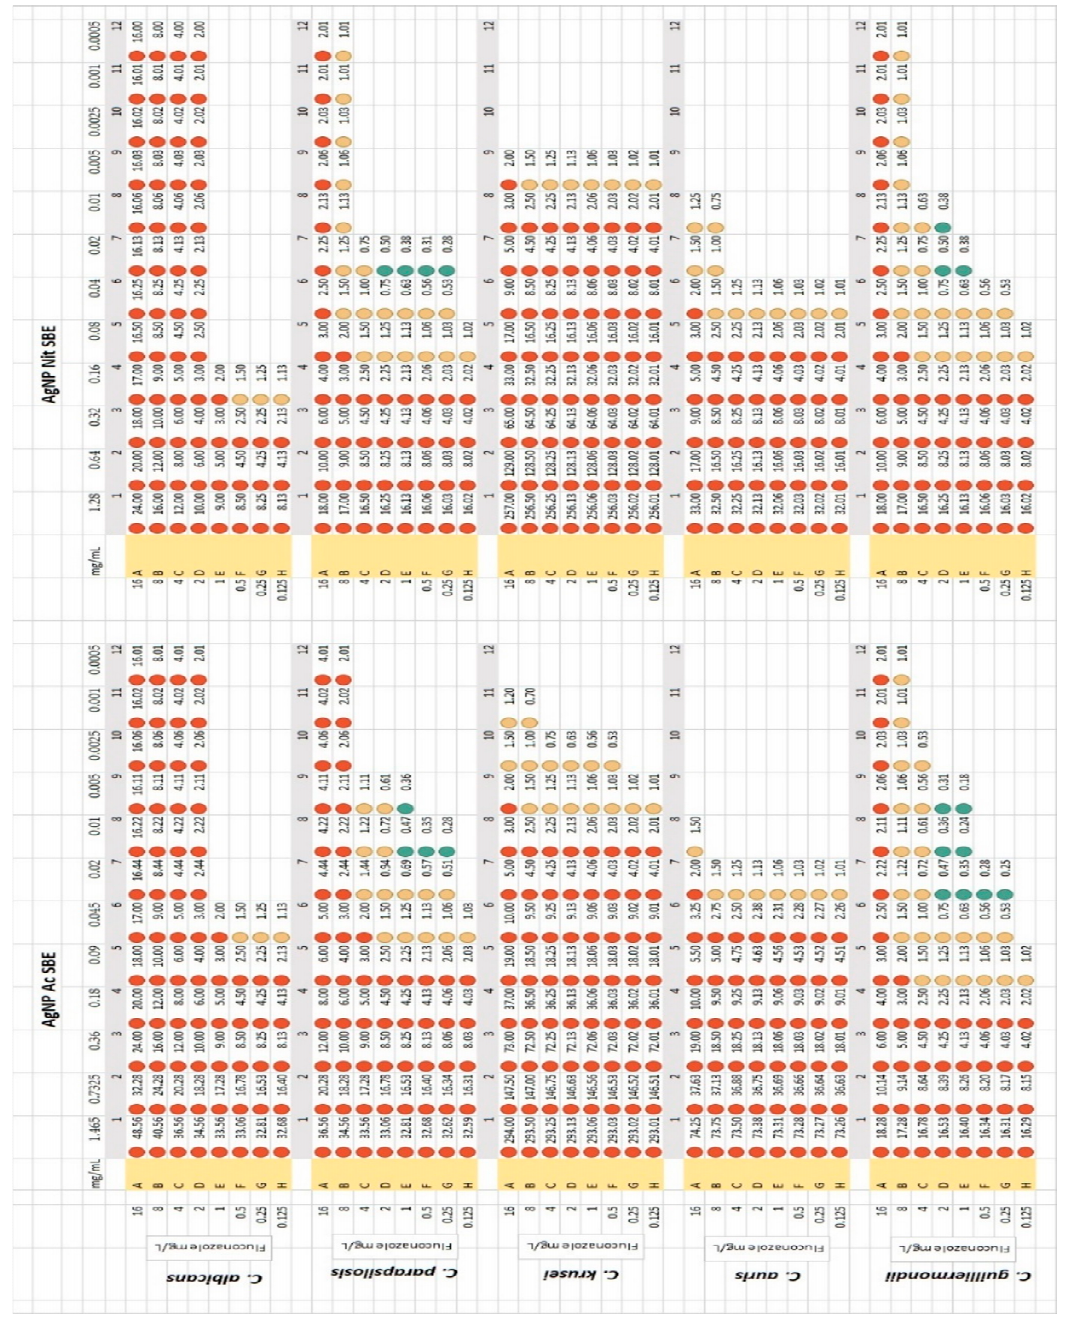
Figure 2. FICs for fluconazole synergy test in the presence of AgNP SBEs (checkerboard method). Synergistic FIC values — marked with green bullets, indifferent FIC values — marked with yellow bullets, antagonistic FIC values — marked with red bullets.